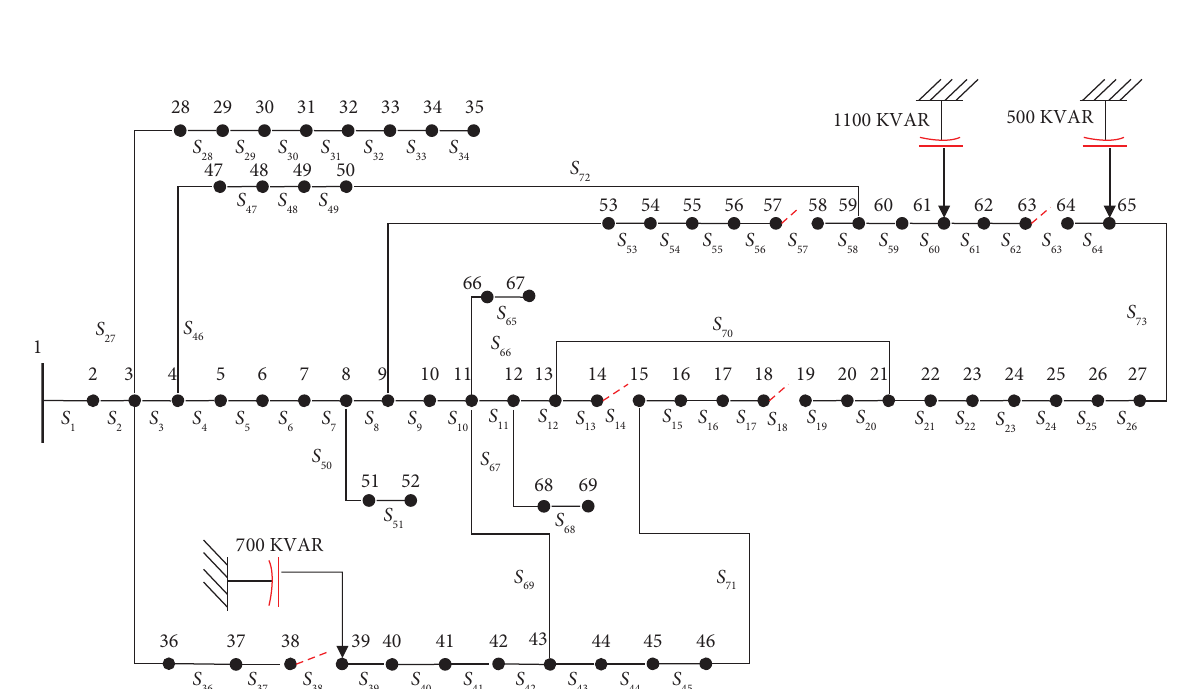
Figure 16: 69-bus IEEE system for scenario